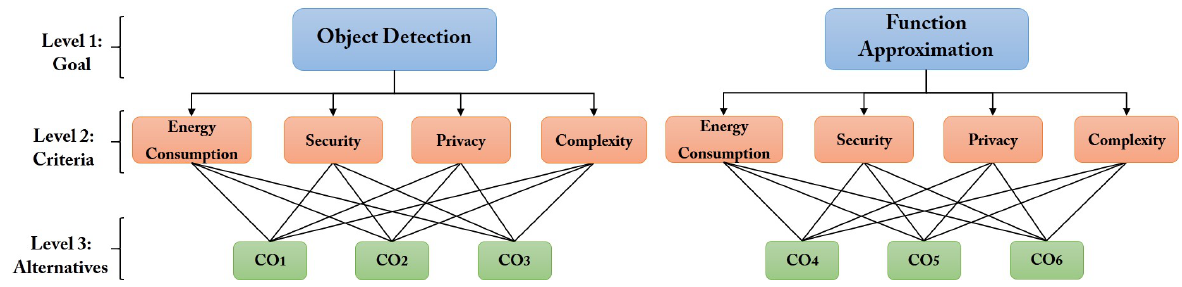
Figure 6. Decision hierarchy for object detection and function approximation.